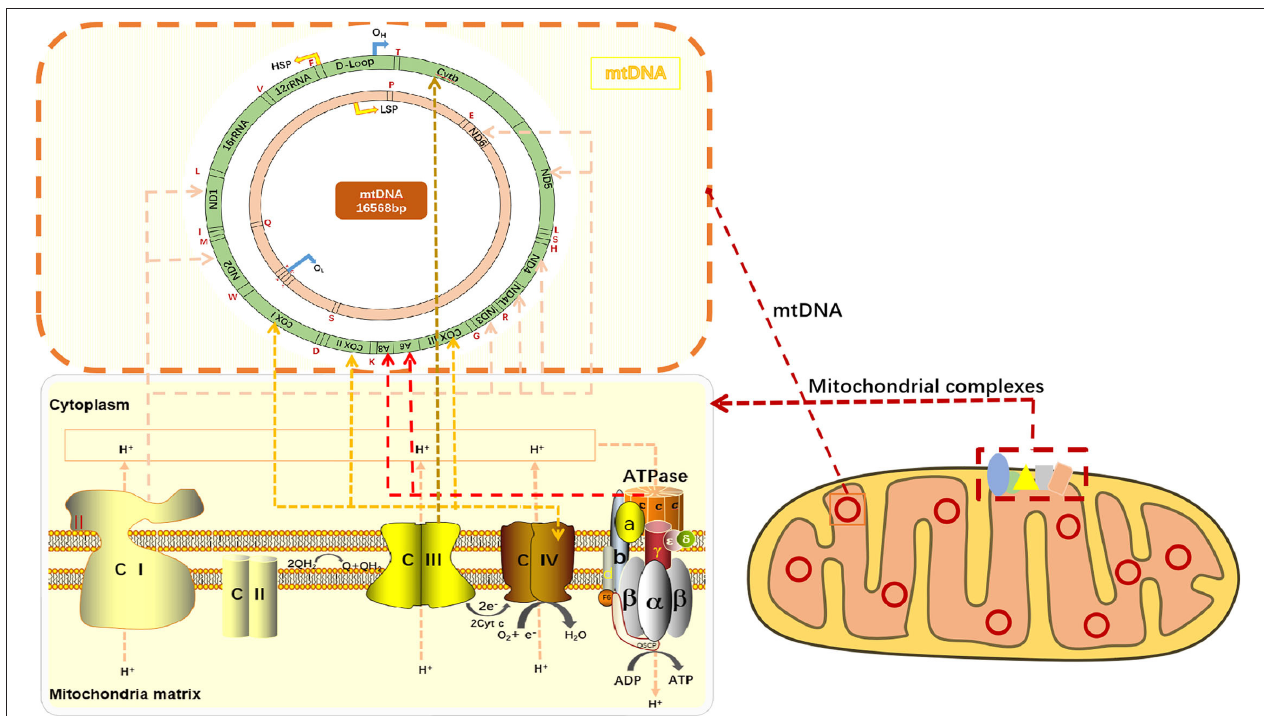
FIGURE 1 | mtDNA encodes respiratory chain complexes for electron transport. Mitochondrial respiratory chain complex I (NADH oxidase) and mitochondrial respiratory chain complex II (succinate dehydrogenase) are the major components of electron entry into mitochondrial electron transport chain (ETC). Complexes I and II catalyze NADH oxidation and succinic acid oxidation to fumaric acid, respectively. Next, coenzyme Q (Q) forms coenzyme (QH2), leading to a decrease in oxygen (the final electron receptor). Mitochondrial respiratory chain complex III (cytochrome c oxidoreductase) is the gatekeeper of the mitochondrial respiratory chain and the main source of reactive oxygen species III, which transfers electrons from panthepanol (reduced coenzyme Q or CoQ) to cytochrome c (cyt c) through a catalytic mechanism of the Q cycle. The mitochondrial respiratory chain complex IV (cytochrome c oxidase) is the final electron acceptor of the mitochondrial ETC, which converts oxygen into water through the oxidation of cyt c, a process associated with ATP synthesis in the mitochondrial membrane. Mitochondrial respiratory chain complex V, also known as F1F0-ATPASE or ATP synthase, works with the four complexes to complete oxidative phosphorylation for ATP production. CI or NADH: Ubiquinone oxidoreductase or NADH encoded by ND1, ND2, ND3, ND4, ND4L, ND5, and ND6 on mtDNA, respectively; CII: dehydrogenase succinic acid, ubiquinone oxidoreductase; CIII: Ubiquinone and ferricytochrome C reducing enzyme encoded by Cytb part on mtDNA, respectively; CIV: CIV, cytochrome c